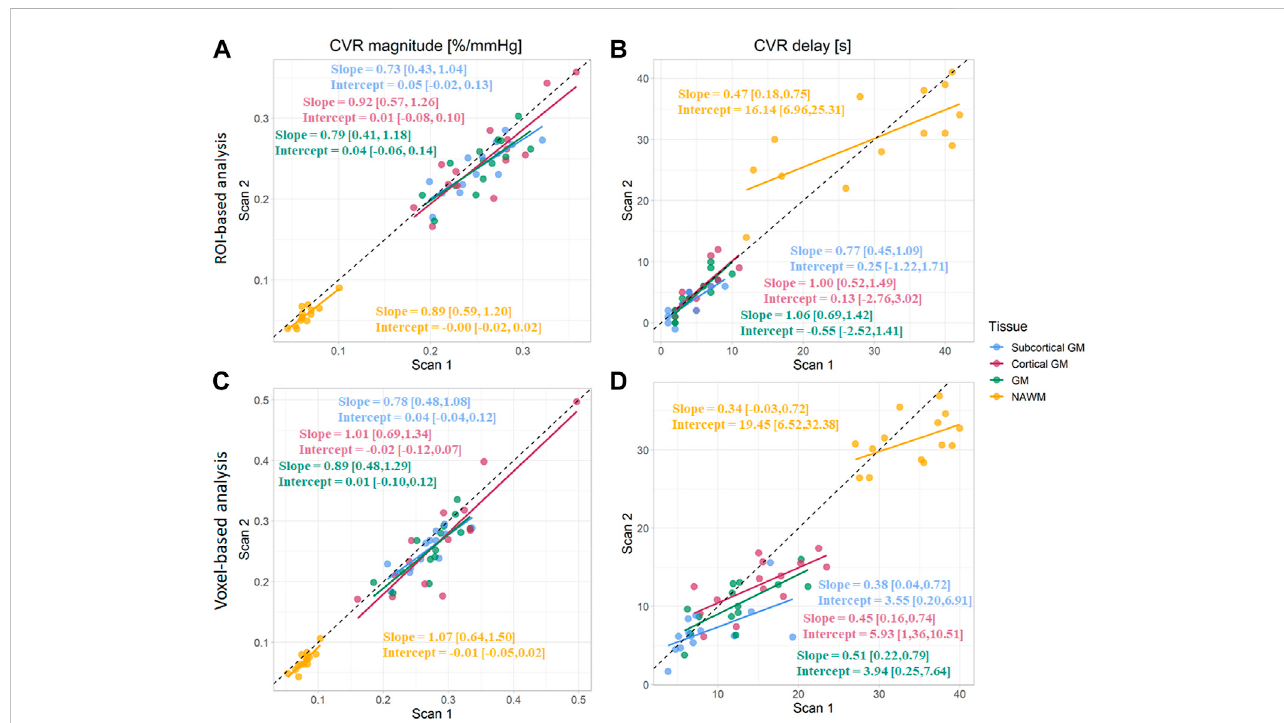
FIGURE 5 Comparison of CVR magnitudes (A, C) and delays (B, D) between scans. Estimates were computed in subcortical GM, cortical GM, GM, and NAWM from the ROI-based (A, B) and voxel-based analysis (C, D) . (GM, Grey matter; NAWM, Normal-appearing white